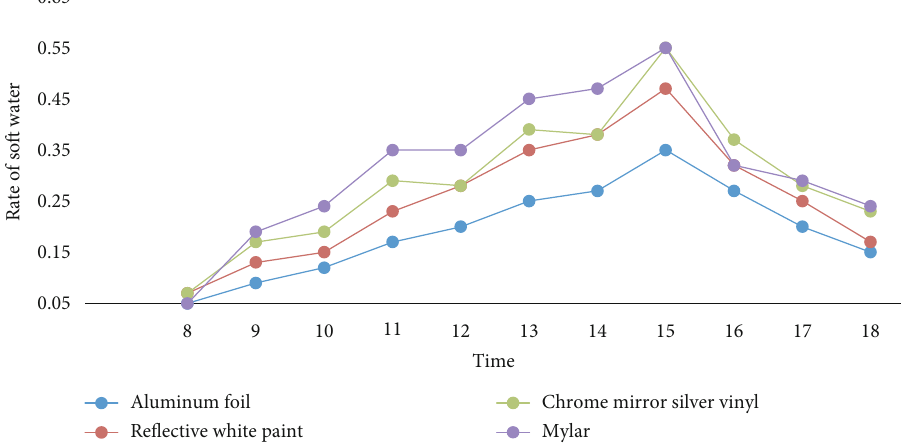
Figure 12: Comparison of various materials on CPC with the rate of generation of soft